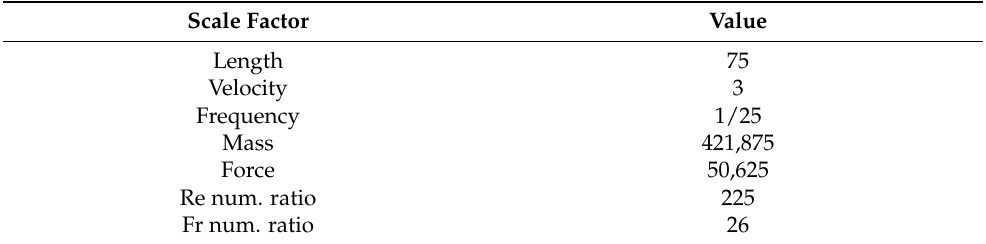
Table 2. Scale factors for the wind turbine model for wind tunnel testing: Politecnico di Milano.